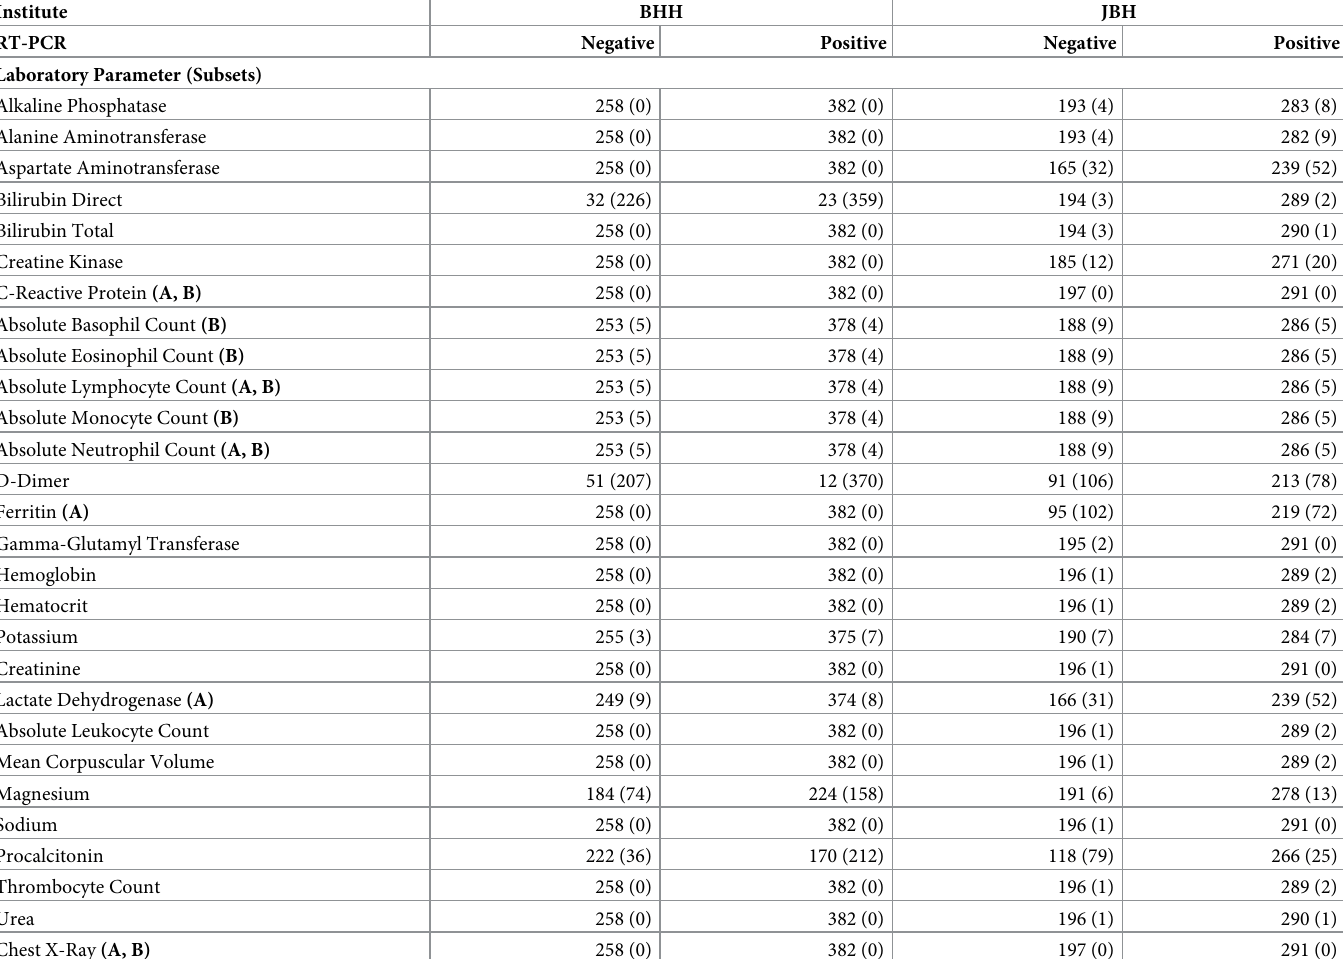
Table 1. Data used in this study from Jeroen Bosch Hospital (JBH) and Bernhoven Hospital (BHH), divided by RT-PCR result. Laboratory and Imaging data parame- ters collected are indicated in the rows. Letters (A, B) are used to indicate which inputs belong to subsets A and B described in Section Data. Numbers of subjects are pro- vided, values in parentheses indicate the numbers of subjects for whom the value was missing or not collected.